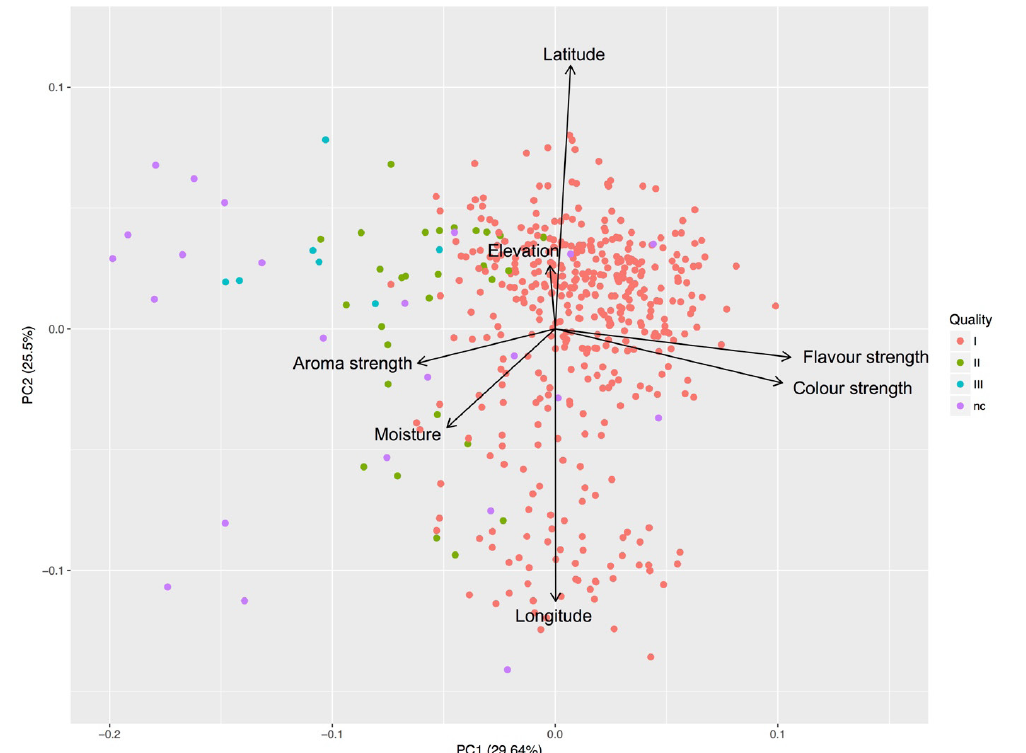
Fig. 8: PCA order biplot of saffron samples associated with geographical (latitude, longitude and elevation) and chemical-physical variables (moisture, flavour strength, color strength and aroma strength). The dots were colored according to the quality category of the samples: I, first quality category; II, second quality category; III, third quality category; nc, not classifiable. The first two principal components (PCs) explain 55.14% of the total variance in the